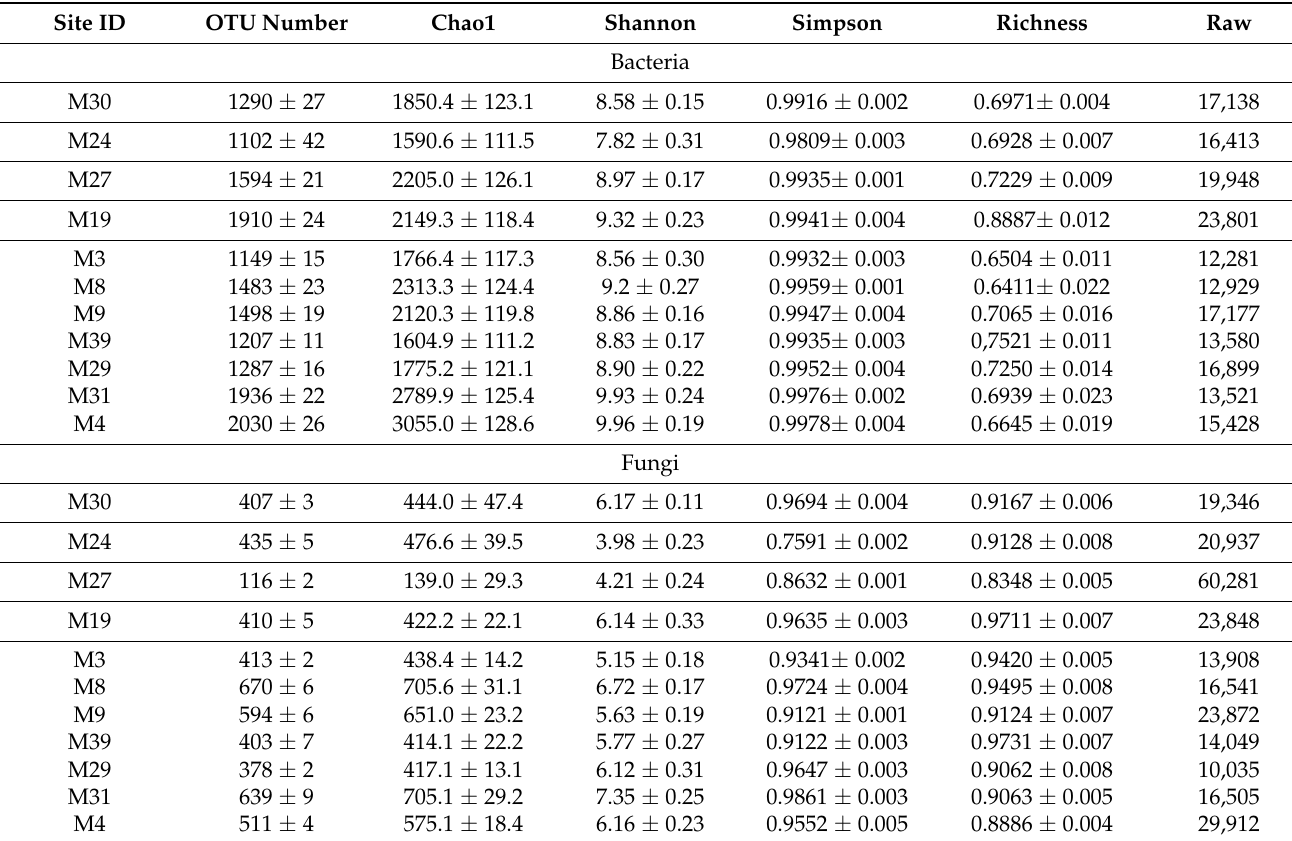
Table 5. Alpha diversity indices of the soil bacterial communities based on the 16S rRNA gene analysis and fungal communities based on ITS